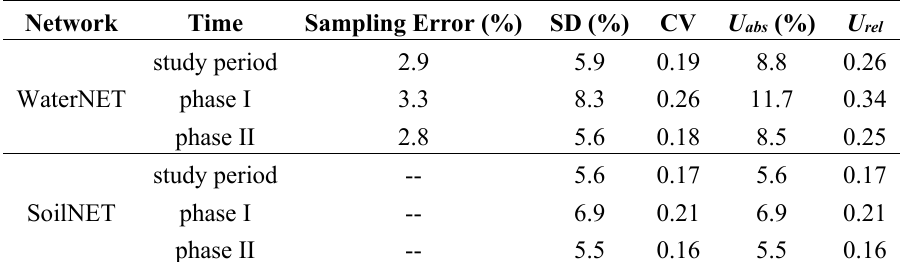
Table 2. Uncertainties of WaterNET and